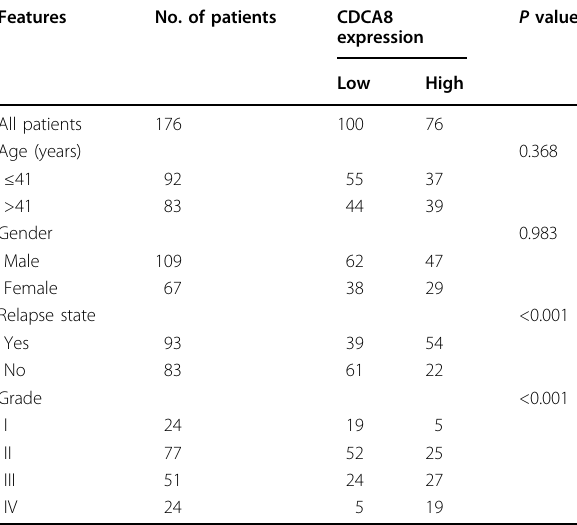
Table 2 Relationship between CDCA8 expression and tumor characteristics in patients with